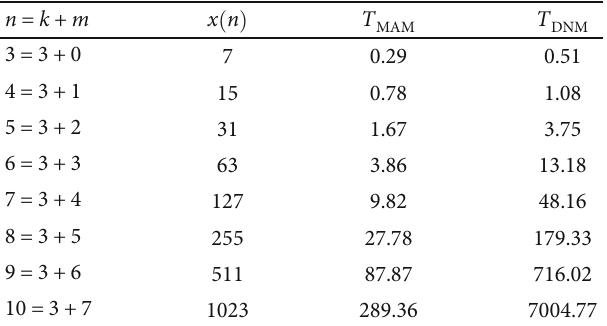
Table 7: Comparison of CPU time between MAM and DNM via linear basis with k = 3, τ = 0 : 005 , and α = 0 : 25 for Example